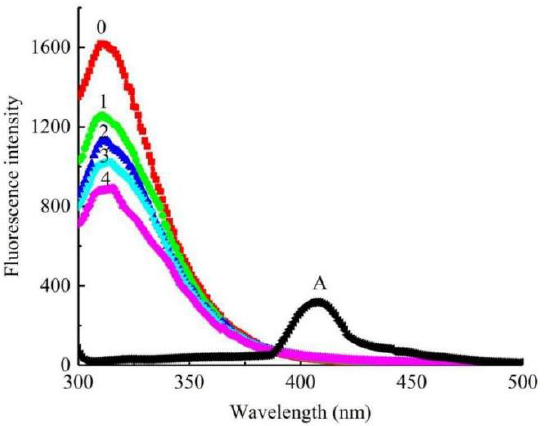
Figure 6. Fluorescence emission spectra of L-DOPA solution in presence of Q1 with different con- centrations. Concentrations of samples for curves 0 – 4 are 0, 9, 18, 27, 36 μM. Curve A is fluorescence emission spectra of Q1 at concentration of 36 μ M.